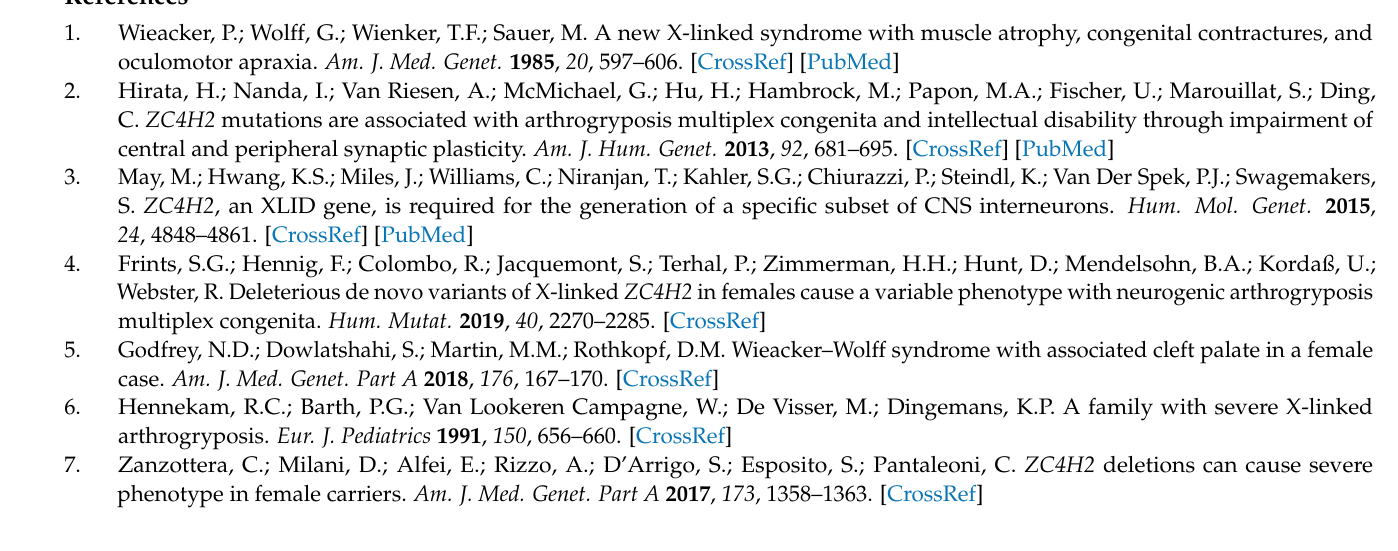
Figure S2: Immunofluorescence of specific markers on the NSCs; Figure S3: Relative expression levels of ZC4H2 in the NSCs infected with lentivirus of shRNA targeting ZC4H2 ; Figure S4: Venny diagram analysis of DEGs. Table S1: The sequences of the shRNA target the human ZC4H2 gene; Table S2: Sequences of TaqMan ® probes for the mitochondria genes; Table S3: Sequences of specific primers for oxidative phosphorylation complex genes; Table S4: Enriched KEGG pathways from the differentially expressed